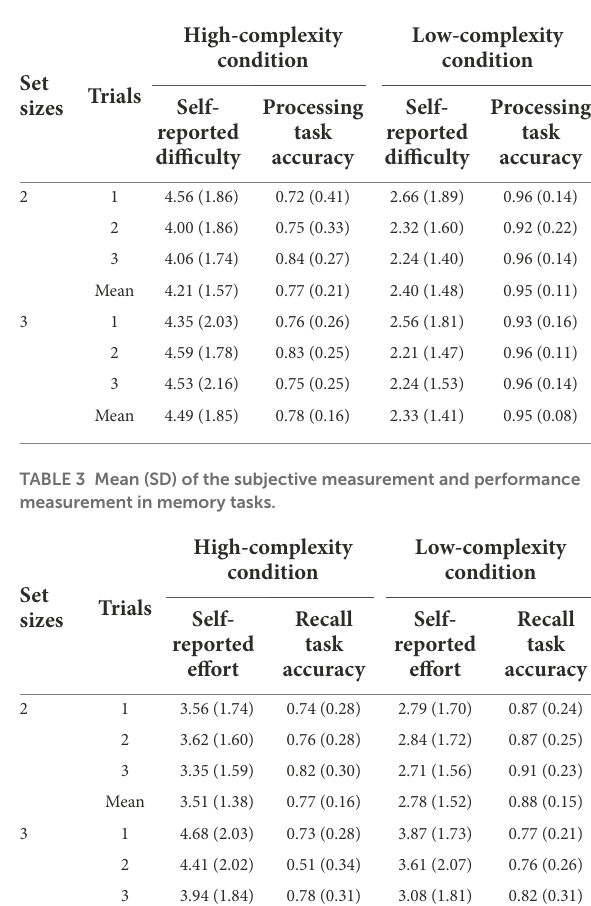
TABLE 2 Mean (SD) of the subjective measurement and performance measurement in processing tasks.